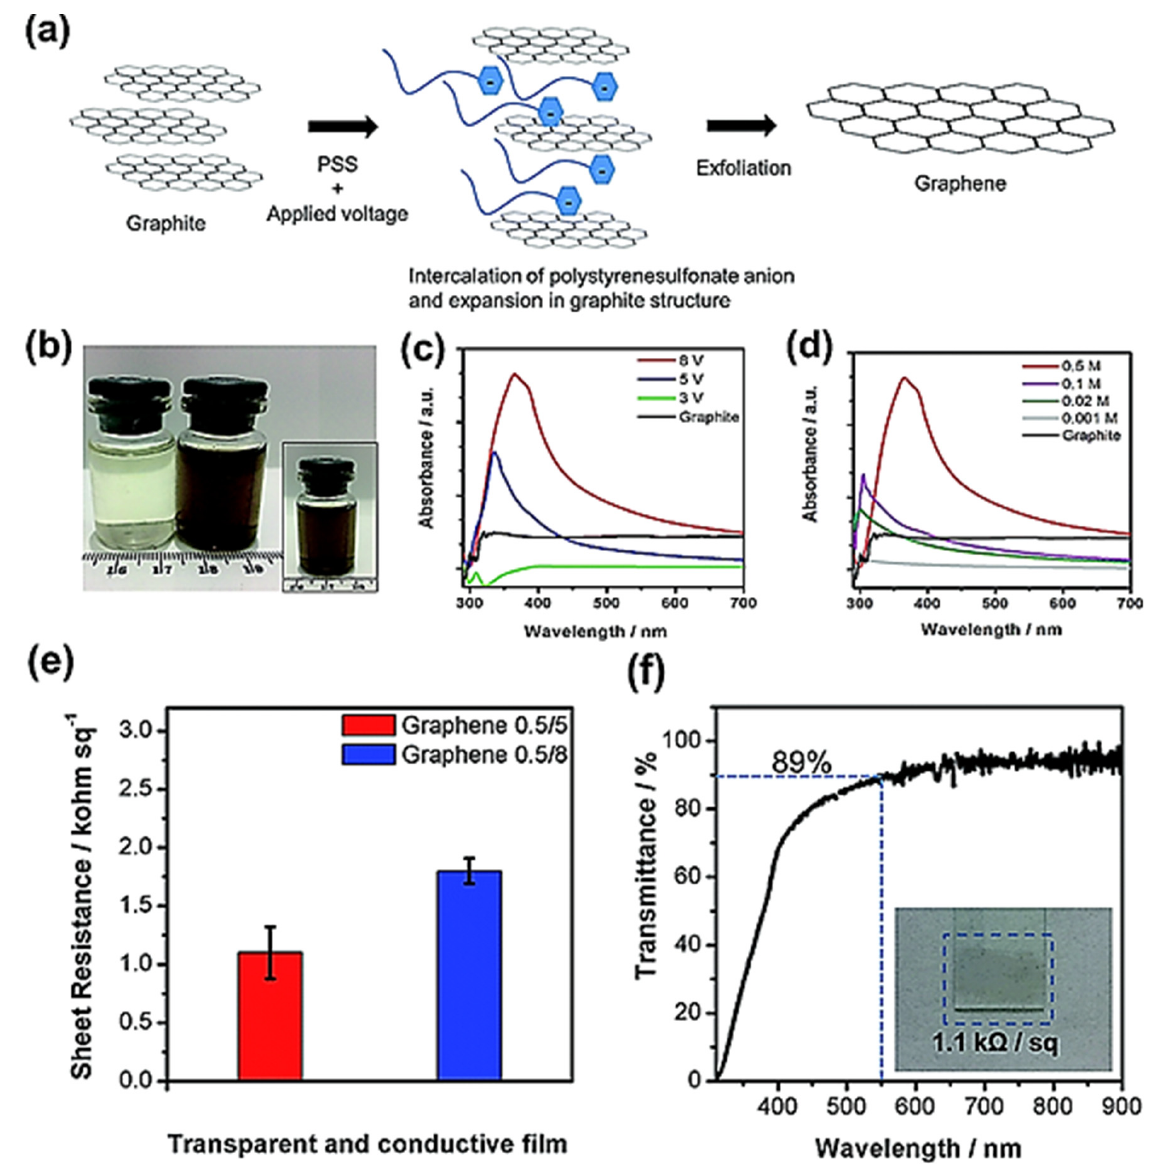
Figure 10. ( a ) Schematic of graphene production process, ( b ) 0.5 M PSS solution graphene-PSS dispersion acquired under 8V DC. ( c , d ) The UV-vis profile at varying and 8V DC voltage, respectively. ( e , f ) Transmittance and sheet resistance-produced samples. Reproduced with permission from [81].